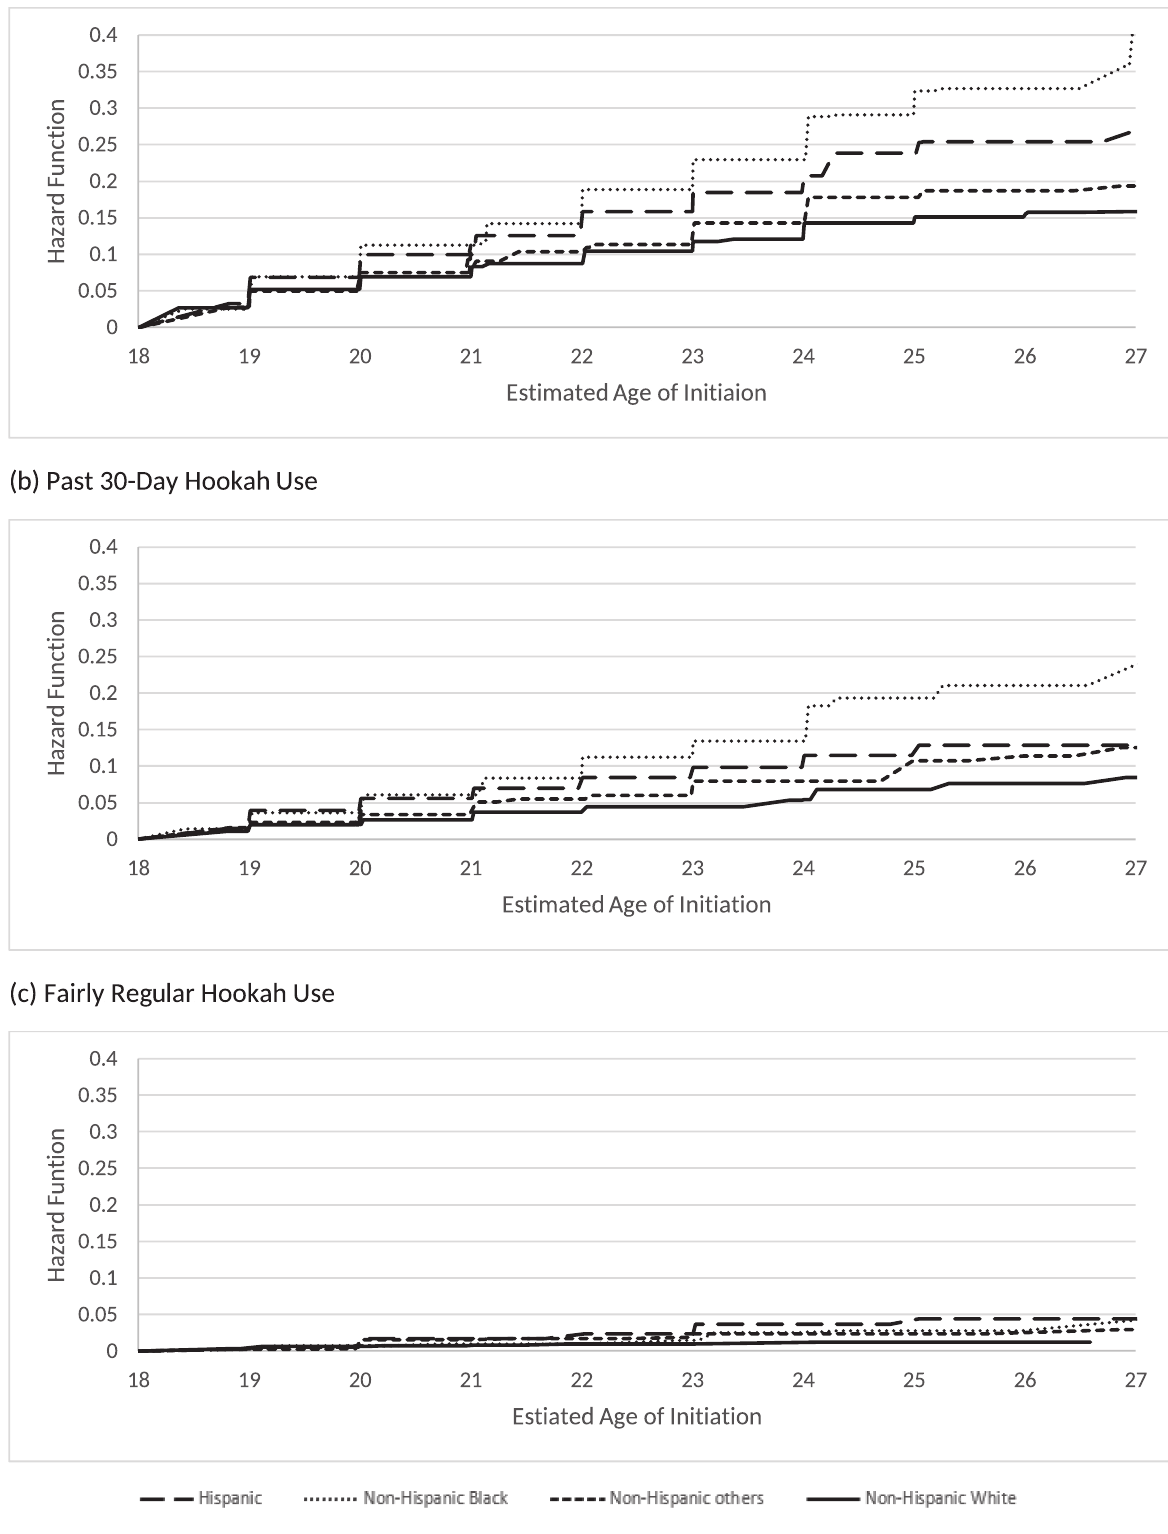
Fig 3. Estimated hazard function of the age of hookah initiation by race/ethnicity. https://doi.org/10.1371/journal.pone.0258422.g003 PLOS ONE | https://doi.org/10.1371/journal.pone.0258422 October 12,